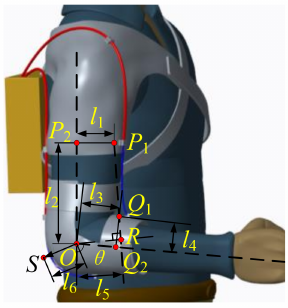
Figure 8. The geometric analysis diagram of flexible